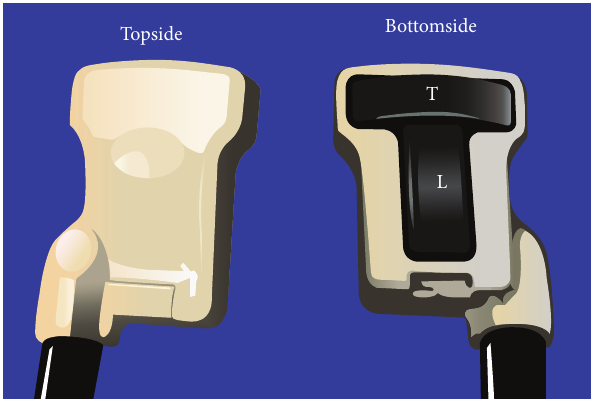
Figure 1: A pictorial depiction of the BK 8824 US probe showing the configuration of the transverse and longitudinal transducers. T: transverse transducers; L: longitudinal transducer.